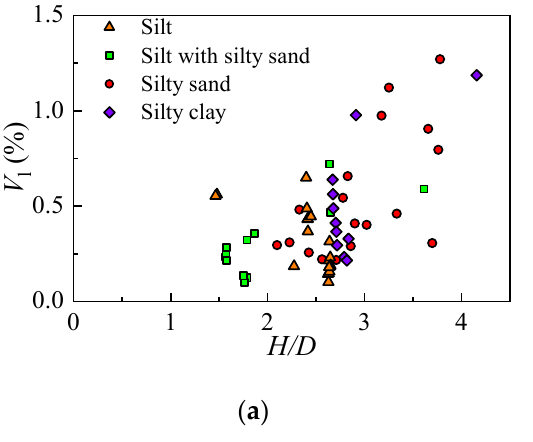
Figure 4. Statistical result of the volume loss V l . ( a ) volume loss V l vs. buried depth H , ( b ) probability distribution of V l .